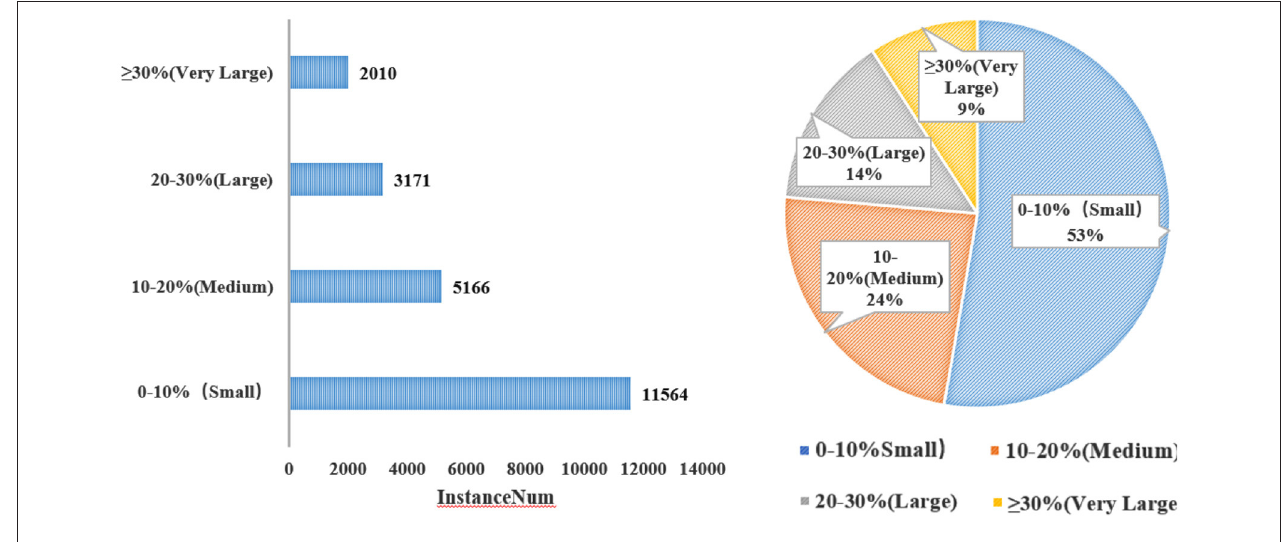
FIGURE 6 | Statistics of the scale of an instance in its image.